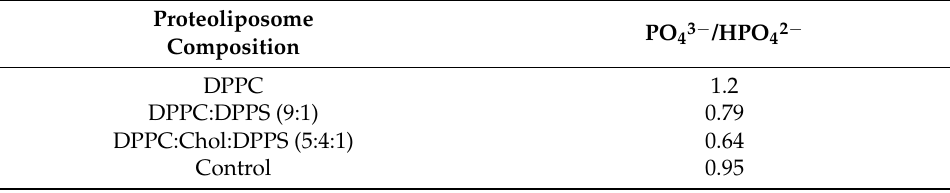
Table 4. Ratios between the intensity of the bands at 1040 (PO 43 − ) and 987 (HPO 32 − ) cm − 1 calculated from the ATR-FTIR spectra (Figure 3) of the mineral precipitated in the in vitro mineralization assay by the AnxA6—containing proteoliposomes and AnxA6 in solution, as a control, in the absence of type-I